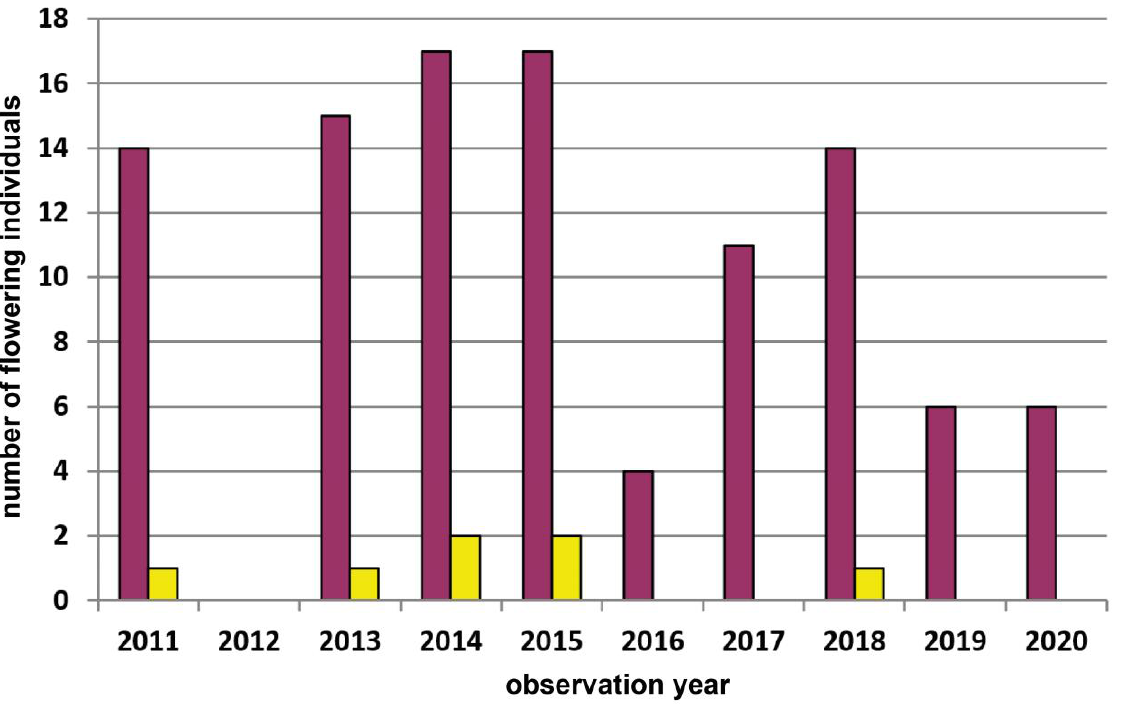
Figure A4. Population census (2011–2020) of the Dactylorhiza sambucina -population Wolfenreith in the Waldviertel region. This population was not visited by us in the year 2012. Red columns = red- flowering plants and yellow columns = yellow-flowering plants.